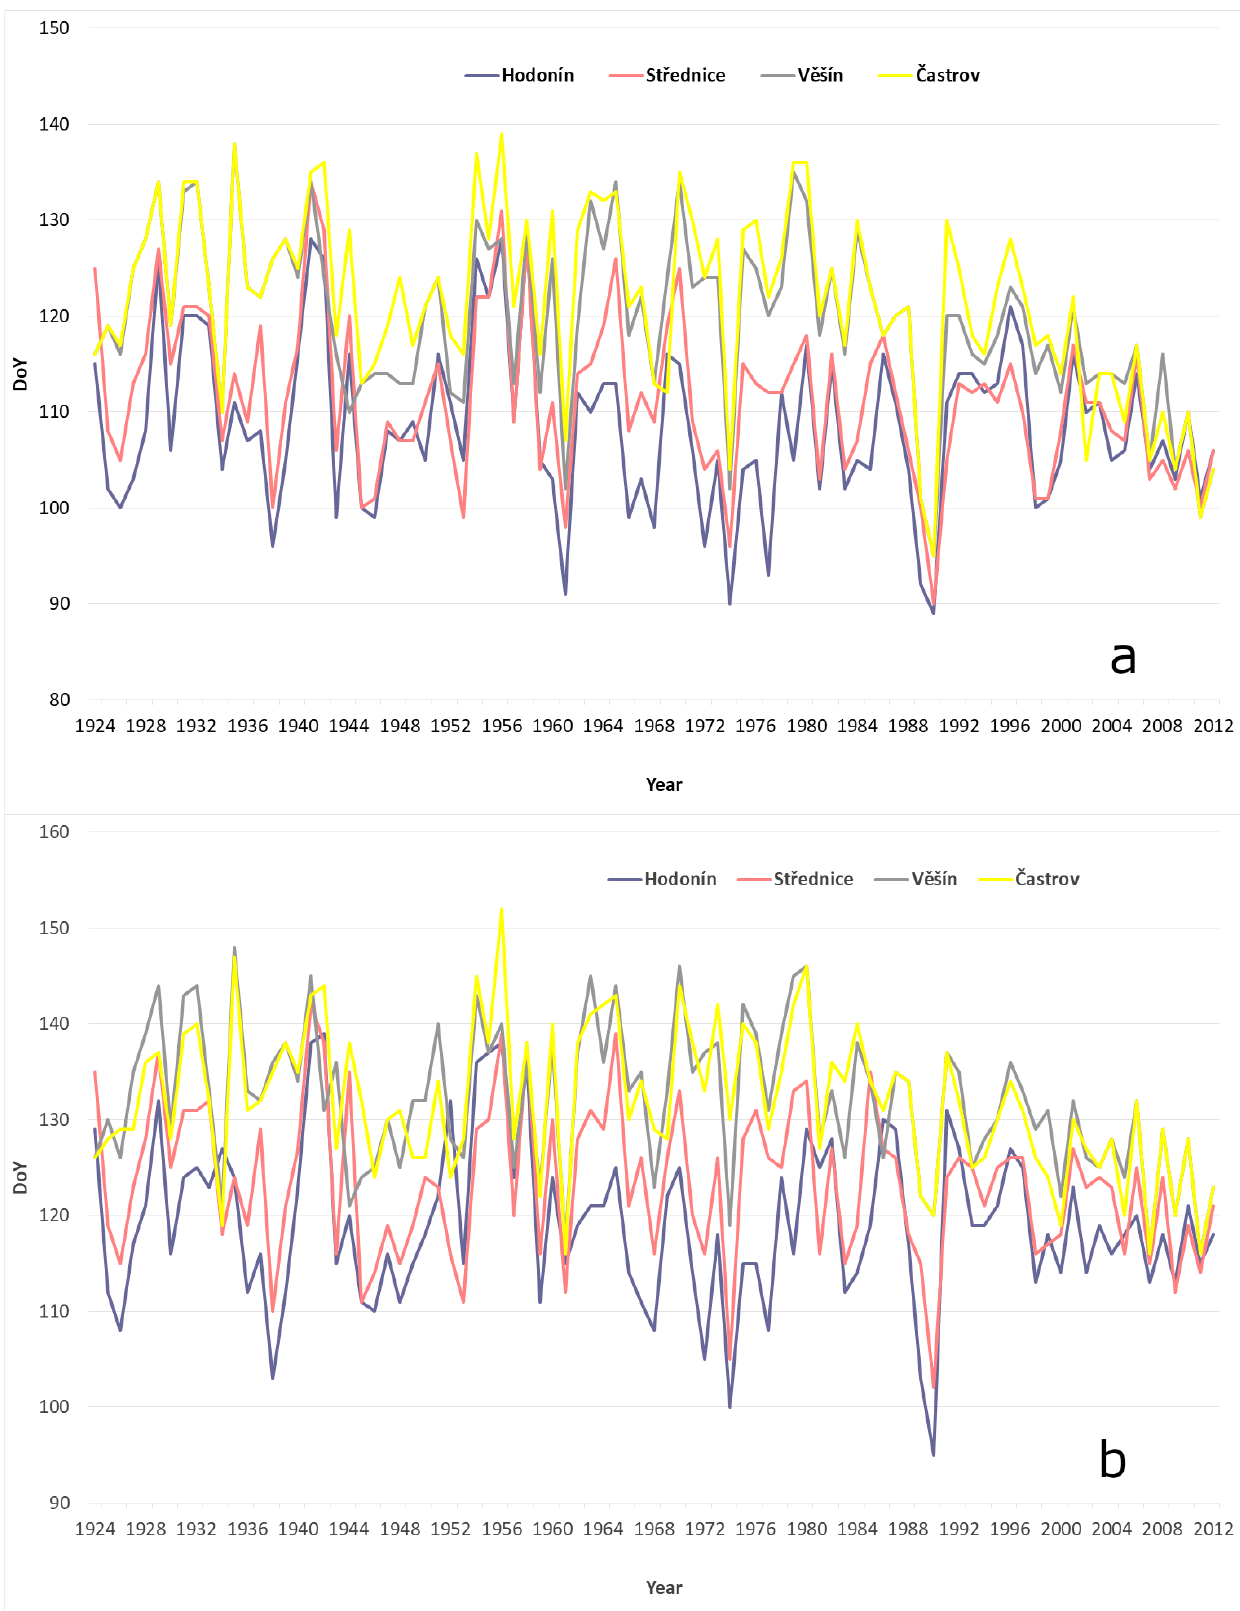
Figure 3. Beginning of flowering ( a ) and end of flowering ( b ) of Cerasus avium at Hodon í n, Stˇrednice, Vˇeš í n and ˇCastrov stations in the period of 1924–2012 (in